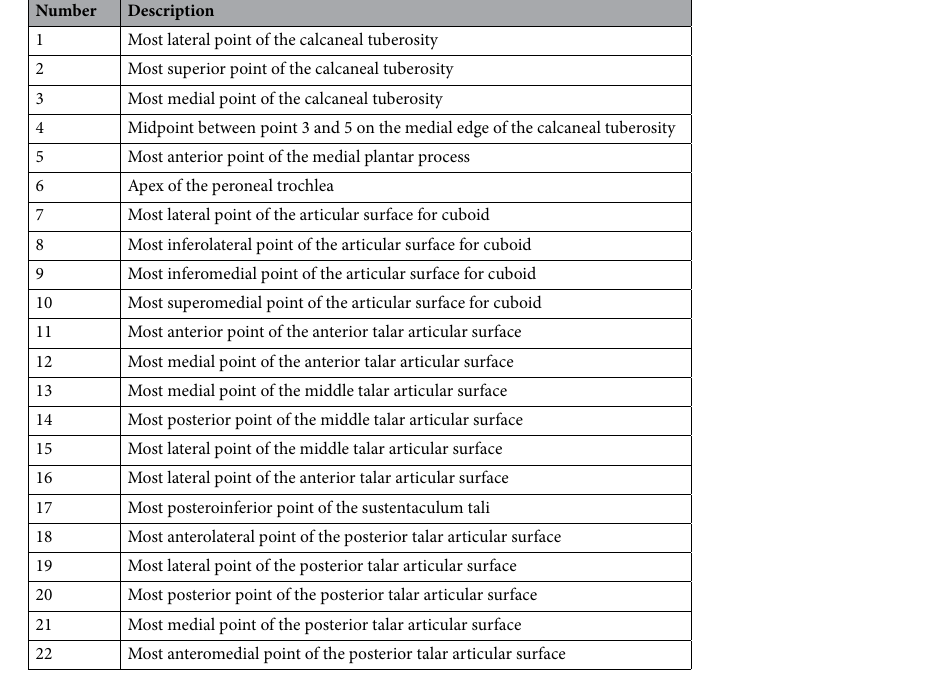
Table 1. Description of landmarks used in this